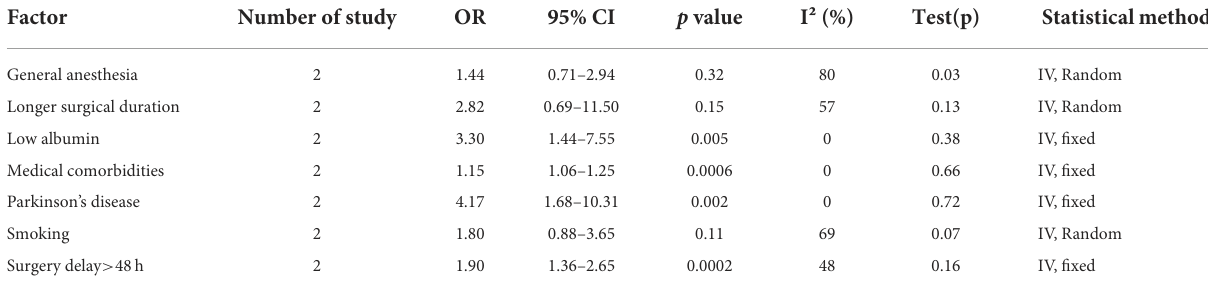
TABLE 1 Results of meta-analysis of other factors.